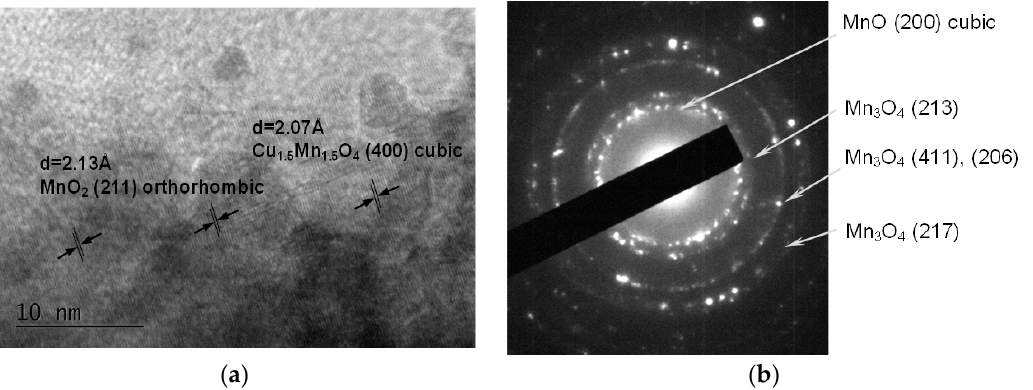
Figure 6. The HRTEM image at a magnification of 600,000× ( a ) and the SAED pattern ( b ) of the Au/CuMn (1:5) catalyst tested in the WGS reaction.